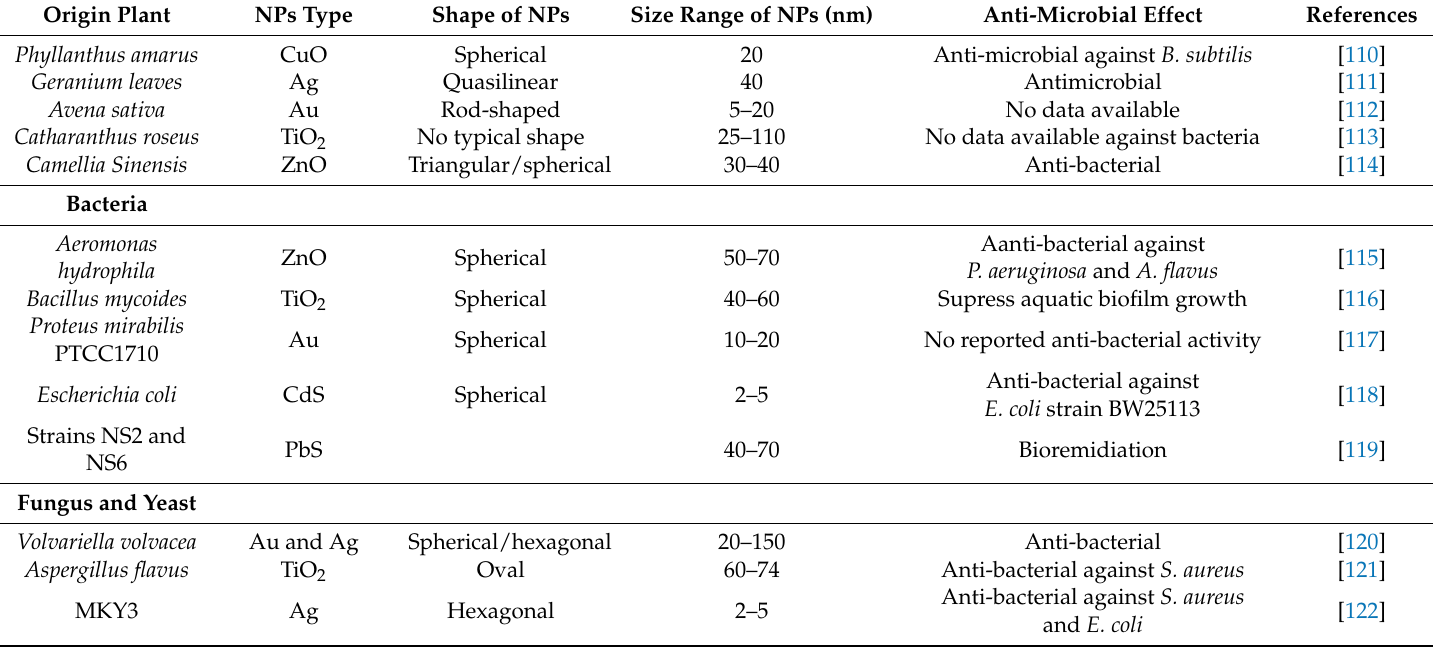
Table 1. Overview of several types of biogenic nanoparticles, their source and reported antimicrobial